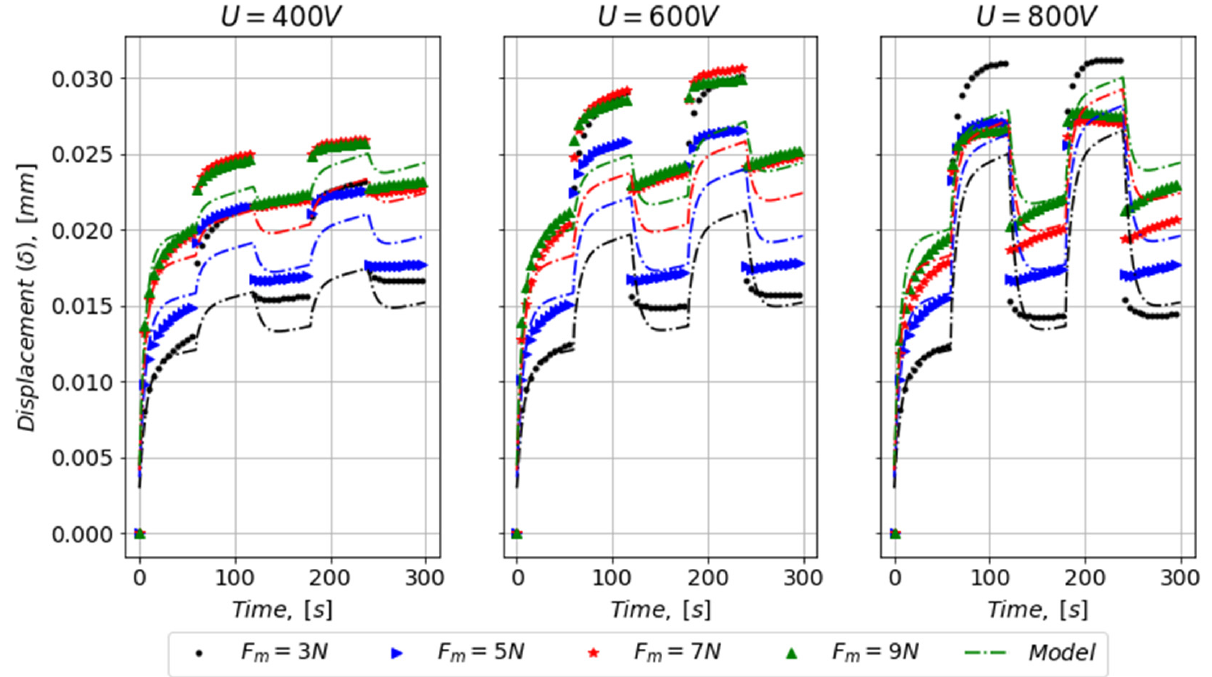
Figure 7. Model predictions against the entire data set.